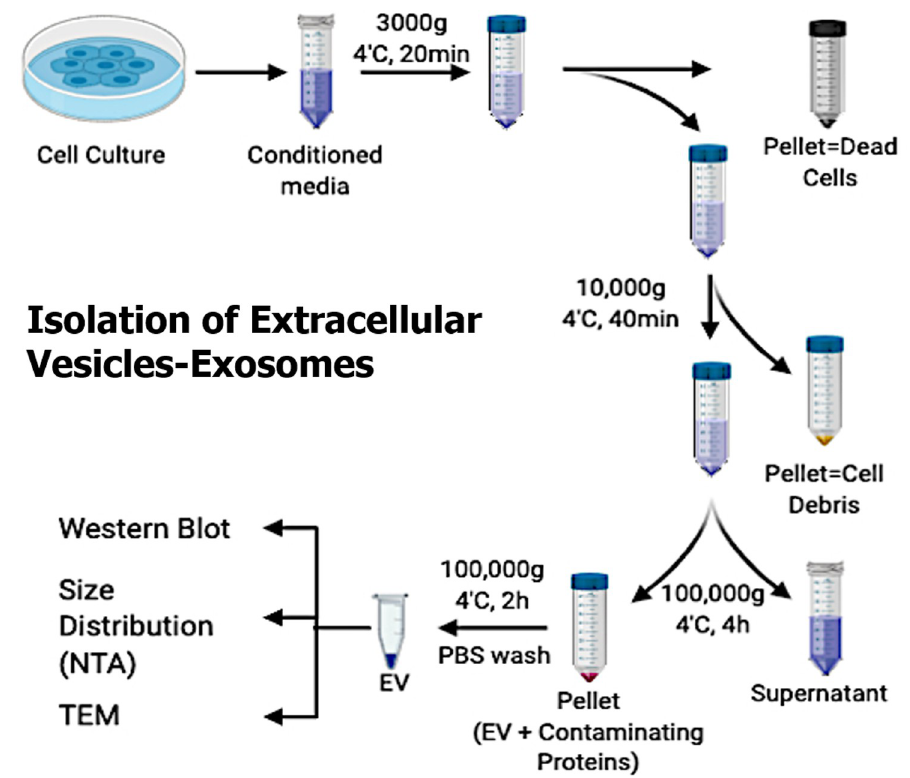
Fig 1. Isolation of exosomes: Schematic representation for the isolation procedure of exosomes from cell- conditioned media.